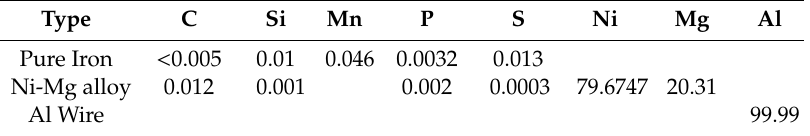
Table 1. Chemical composition of raw materials (in mass percent,